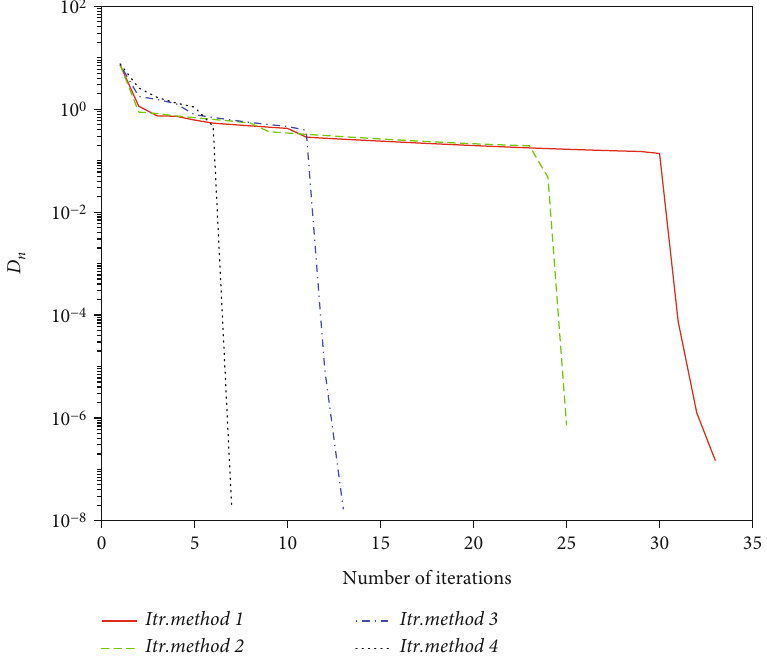
Figure 13: All methods are compared computationally while x